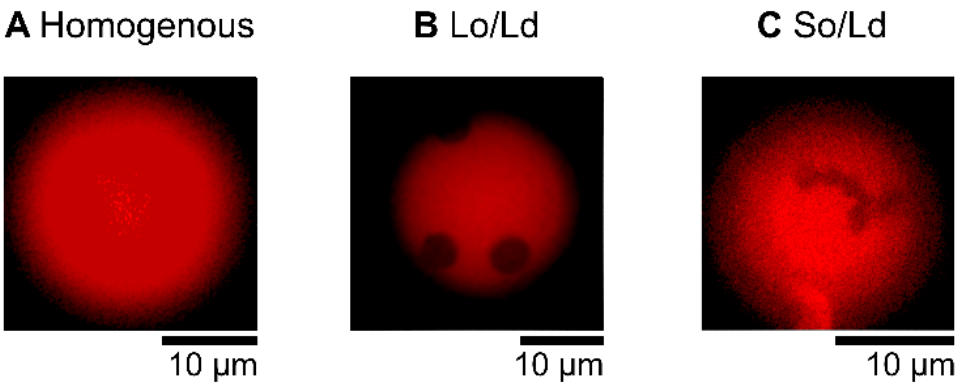
Figure 1. Microscopic images of multicomponent liposomes. Homogeneous (Ld) phase (DOPC/DPPC 50:50, ( A ), Lo/Ld phase separation (DOPC/DPPC/Chol 40:40:20, ( B ), and So/Ld phase separation (DOPC/DPPC 50:50, ( C ). Bright regions indicate the Ld phase ( A – C ), and dark regions indicate the So and Lo phases in ( B , C ), respectively. The Ld phase was labeled with a fluorescent dye (Rhodamine-DHPE). Rhodamine DHPE should be almost entirely distributed throughout the Ld phase [44].